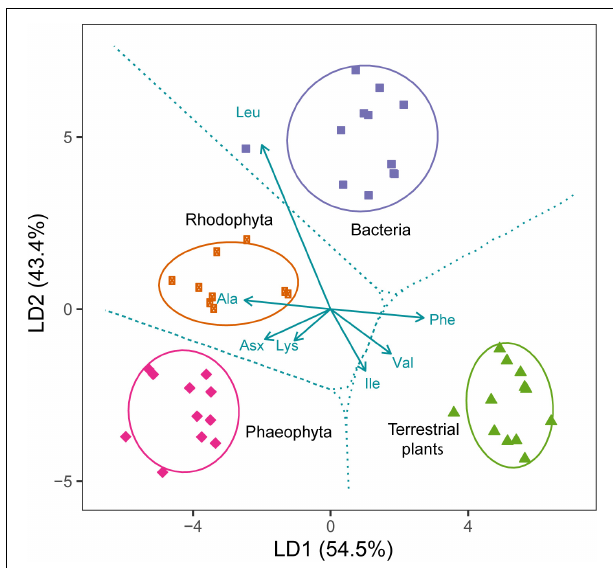
FIGURE 3 | Linear function discriminant analysis (LDA) based on the seven most discriminate amino acid δ 13 C variables for separating bacteria ( n = 12), Phaeophyta ( n = 11), Rhodophyta ( n = 9) and terrestrial plants ( n = 12). Insufficient data available for Chlorophyta. Values in parentheses are the percentage variations accounted by each LD axis (54.5 and 43.4% for LD1 and LD2, respectively), the ellipses represent the 95% confidence intervals of each group, and the broken lines represent the decision boundaries. The median values of the four groups are significantly different (Pillai’s Trace = 1.90, F 6 , 80 = 247.1; p < 0.001). The data were compiled from Larsen et al. (2013).